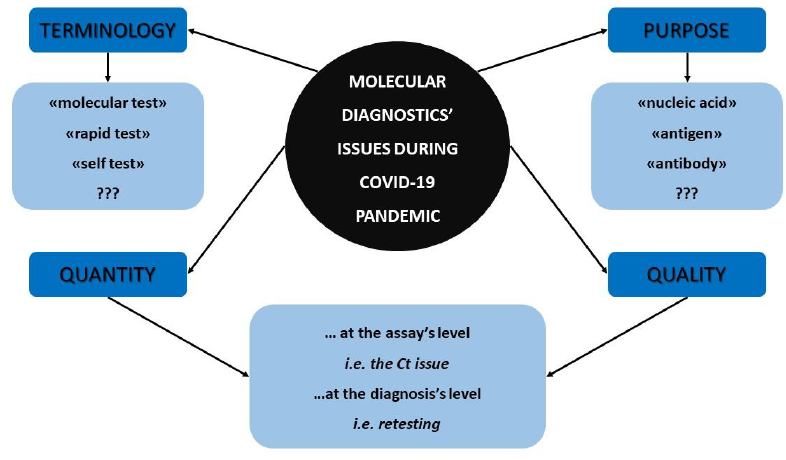
Figure 1. The major molecular diagnostics’ concerns that arose during COVID-19 pandemic.